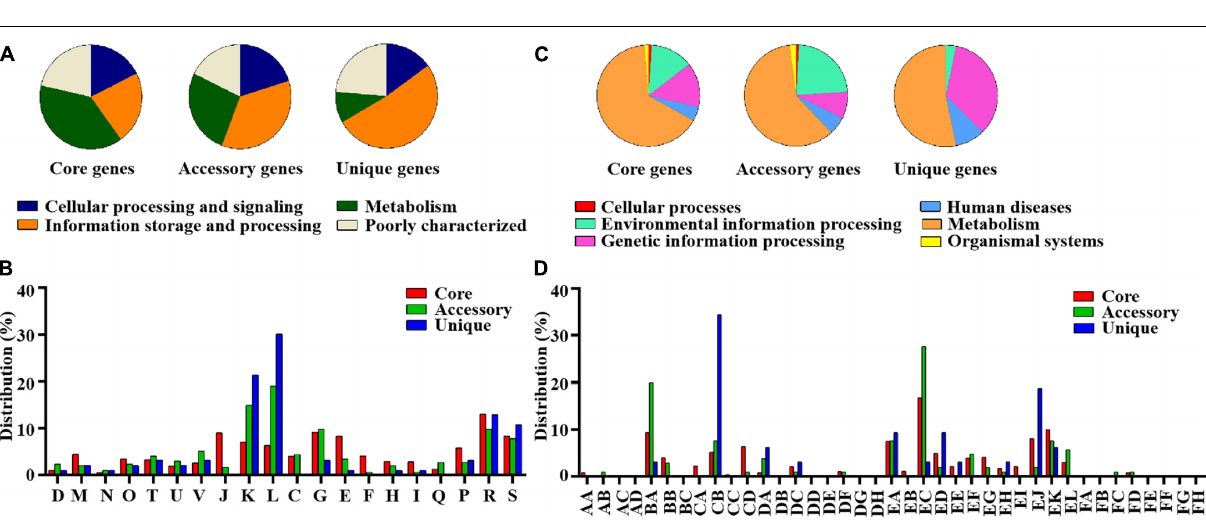
FIGURE 7 | Differential distribution of COG and KEGG functional categories in core, accessory and unique genes: (A) Proportion of 4 classes of COG functional categories in core, accessory and unique genes. (B) COG functional sub-categories in core, accessory and unique genes. (C) Proportion of 6 classes of KEGG functional categories in core, accessory and unique genes. (D) KEGG functional sub-categories in core, accessory and unique genes. D, Cell cycle control, cell division, and chromosome partitioning; M, Cell wall/membrane/envelope biogenesis; N, Cell motility; O, Post-translational modification, protein turnover, and chaperones; T, Signal transduction mechanisms; U, Intracellular trafficking, secretion, and vesicular transport; V, Defense mechanisms; J, Translation, ribosomal structure and biogenesis; K, Transcription; L, Replication, recombination and repair; C, Energy production and conversion; G, Carbohydrate transport and metabolism; E, Amino acid transport and metabolism; F, Nucleotide transport and metabolism; H, Coenzyme transport and metabolism; I, Lipid transport and metabolism; Q, Secondary metabolites biosynthesis, transport, and catabolism; P, Inorganic ion transport and metabolism; R, General function prediction only; S, Function unknown. AA, Cell growth and death; AB, Cell motility; AC, Cellular community; AD, Transport and catabolism; BA, Membrane transport; BB, Signal transduction; BC, Signaling molecules and interaction; CA, Folding, sorting and degradation; CB, Replication and repair; CC, Transcription; CD, Translation; DA, Cancers; DB, Cardiovascular diseases; DC, Drug resistance; DD, Endocrine and metabolic diseases; DE, Immune diseases; DF, Infectious diseases; DG, Neurodegenerative diseases; DH, Substance dependence; EA, Amino acid metabolism; EB, Biosynthesis of other secondary metabolites; EC, Carbohydrate metabolism; ED, Energy metabolism; EE, Glycan biosynthesis and metabolism; EF, Lipid metabolism; EG, Metabolism of cofactors and vitamins; EH, Metabolism of other amino acids; EI, Metabolism of terpenoids and polyketides; EJ, Nucleotide metabolism; EK, overview; EL, Xenobiotics biodegradation and metabolism; FA, Circulatory system; FB, Development; FC, Digestive system; FD, Endocrine system; FE, Environmental adaptation; FF, Excretory system; FG, Immune system; FH, Nervous system; FI, Sensory